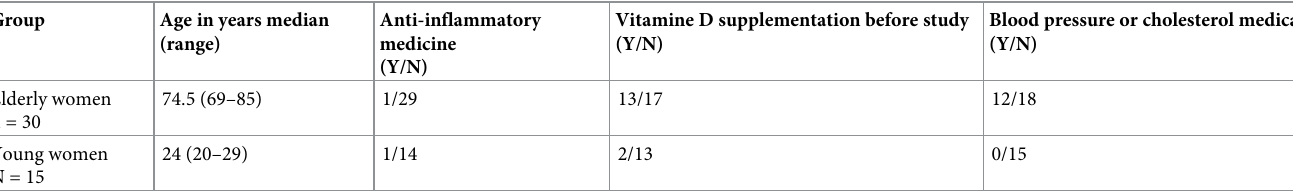
Table 1. Demographics of elderly and young adult study population. Group Age in years median